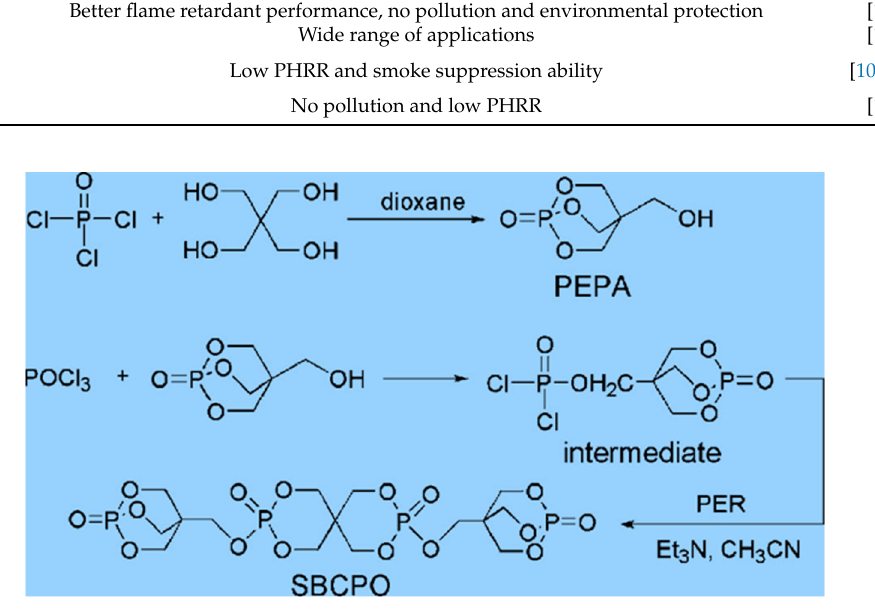
Figure 5. Synthesis route of SBCPO.